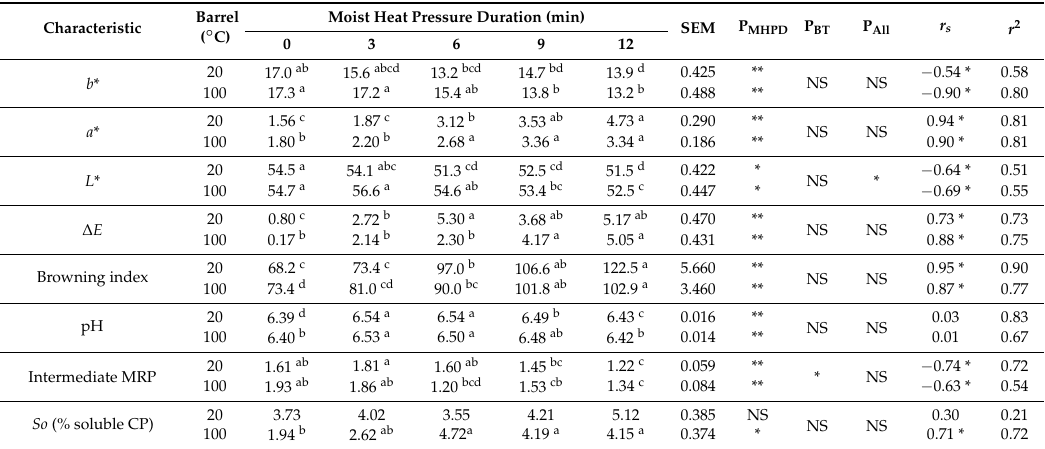
Table 3. Monitoring of Maillard reaction product formation in cold-pressed (20 ◦ C) and expeller (100 ◦ C) canola meals with moist heat pressure treatment for durations of 0, 3, 6, 9 or 12